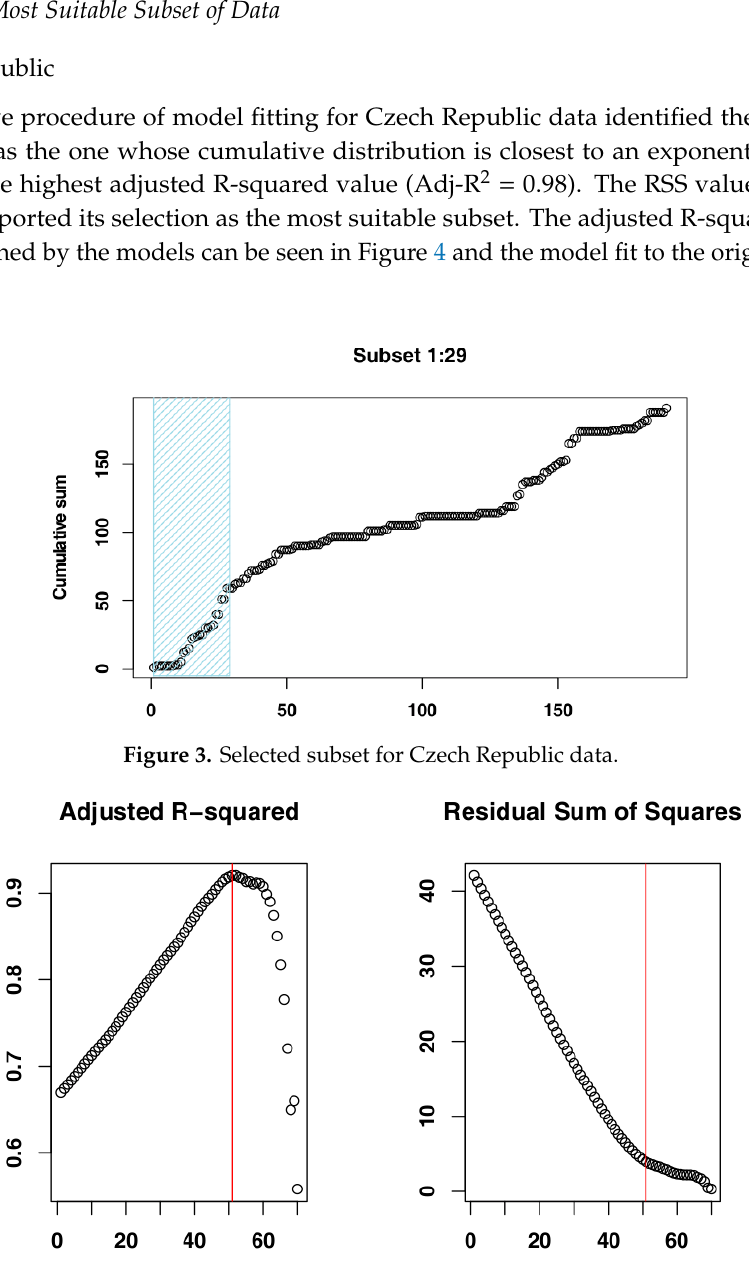
Figure 4. Adjusted R-square and residual sum of squares (RSS) values returned by the iterative procedure applied to Czech Republic data. The red line indicates the values for the selected subset. Numbers on the x -axis are the iteration IDs.